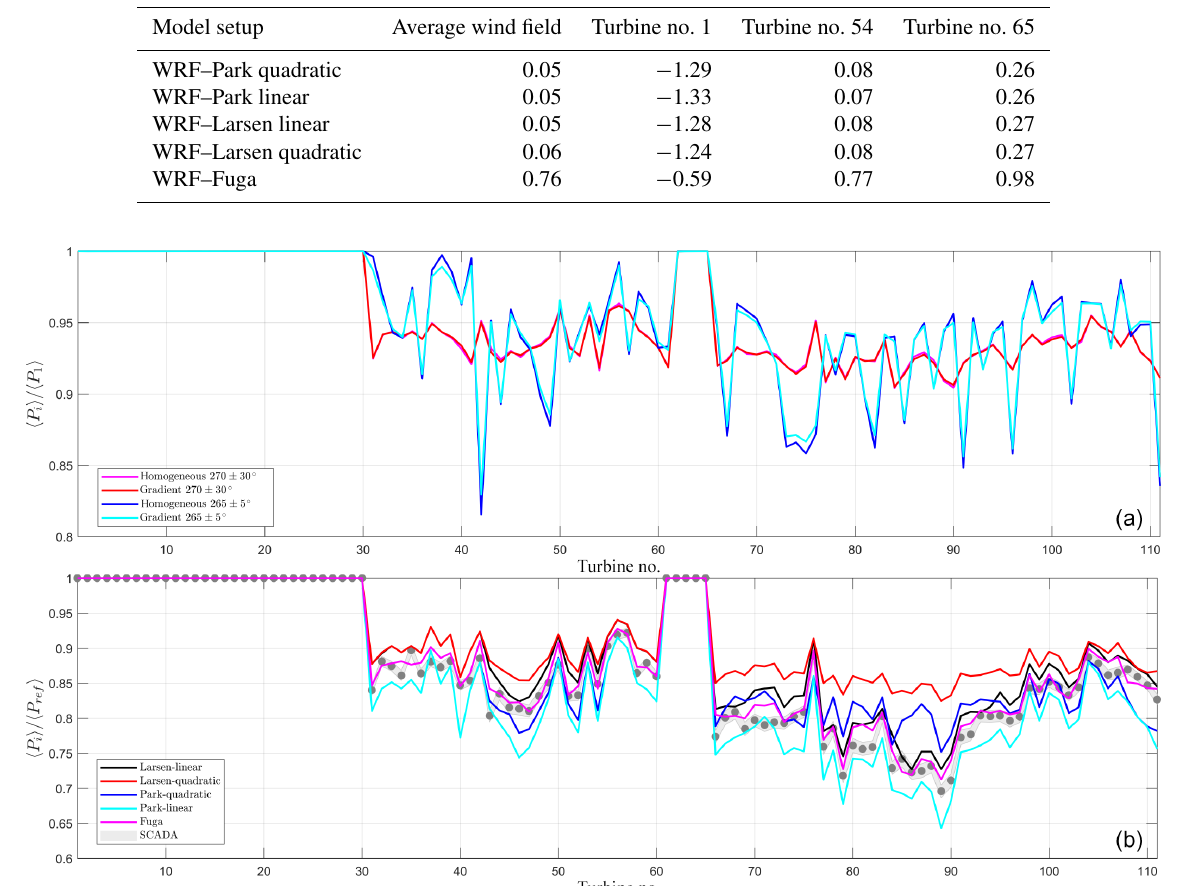
Table 2. Difference (in percentage) between different types of AEP calculations and that using the horizontal wind-speed gradient informa- tion from the WRF simulations.